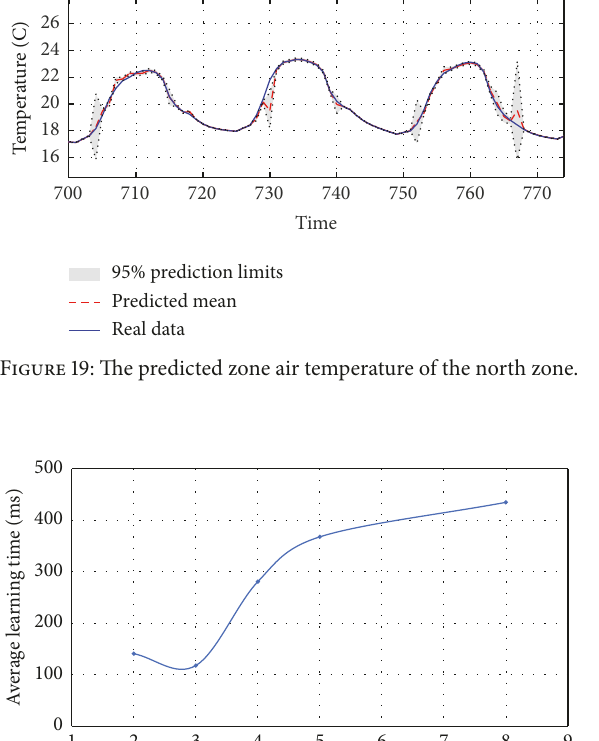
368 ms for the two-zone building and the five-zone building, respectively. Further, the average prediction time was 1 ms for both